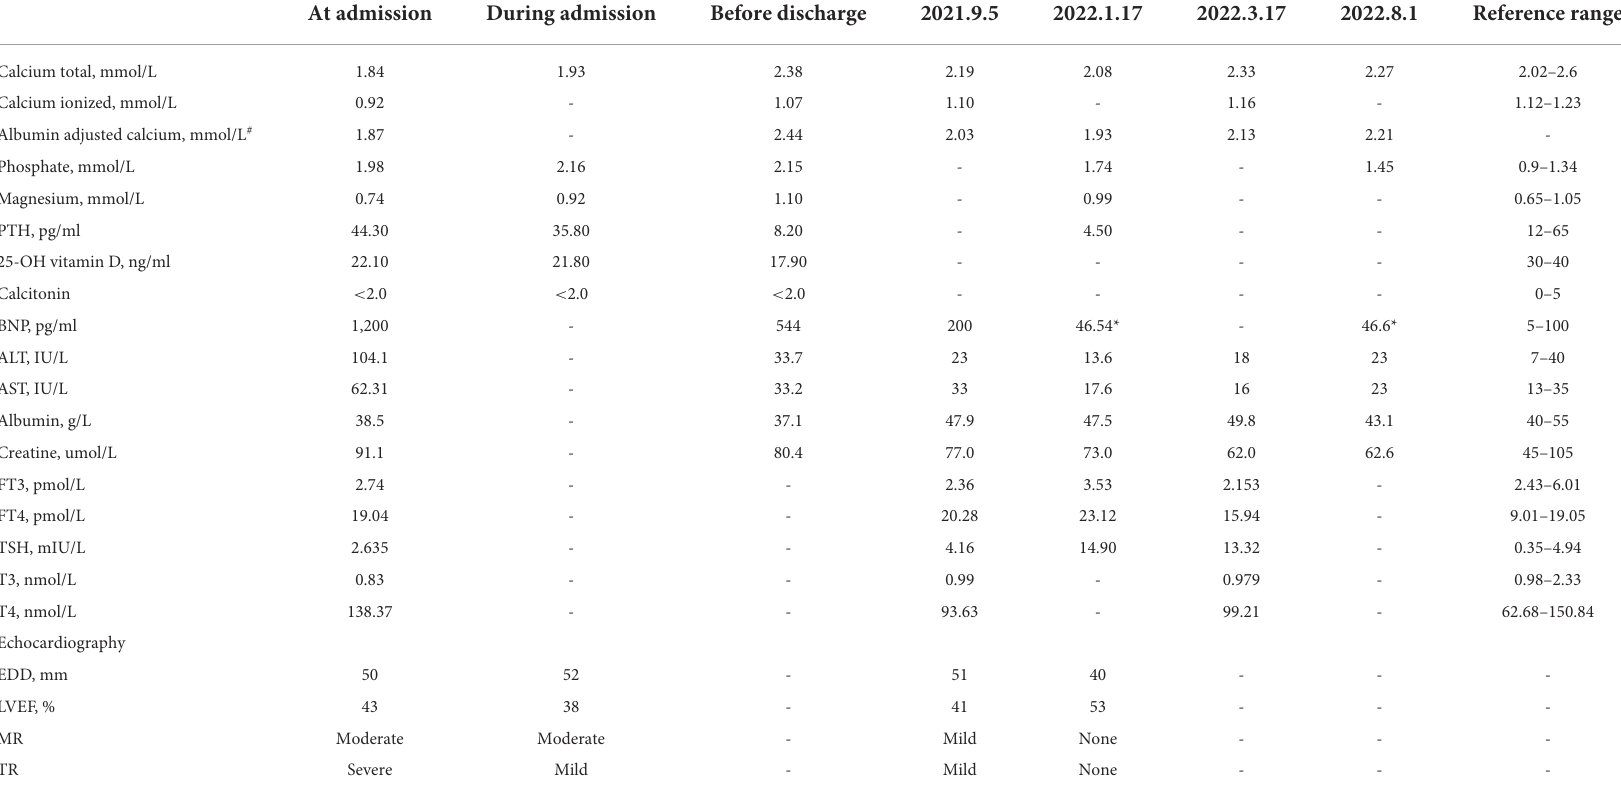
TABLE 1 Laboratory values and echocardiography